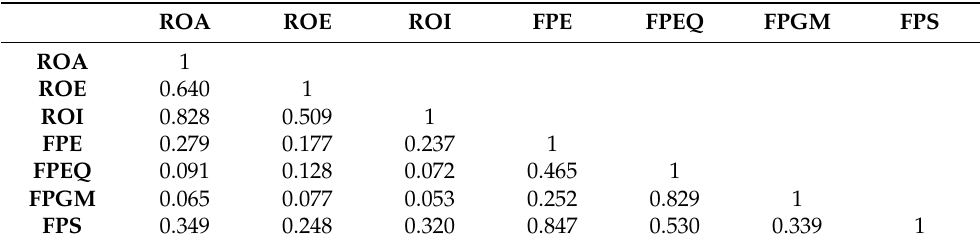
Table 6. The correlation matrix for oil